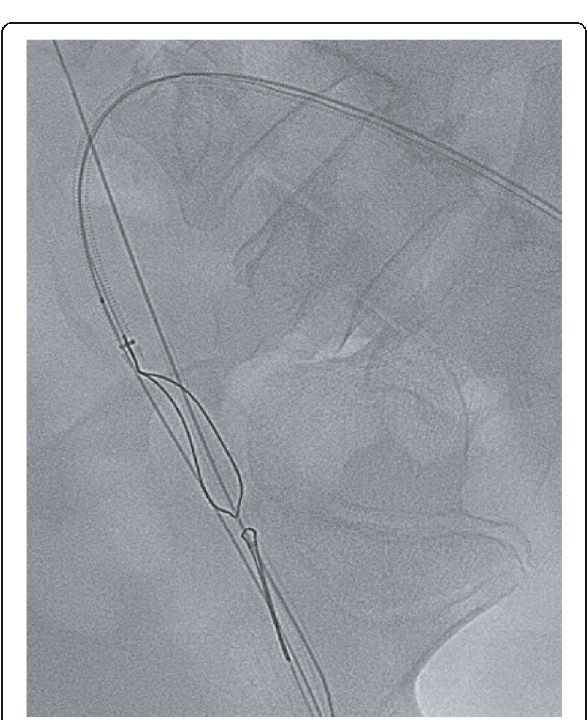
Fig. 4 Snaring of the foreign body from both ends and attempted retraction in the Destination sheath that had been advanced from the contralateral